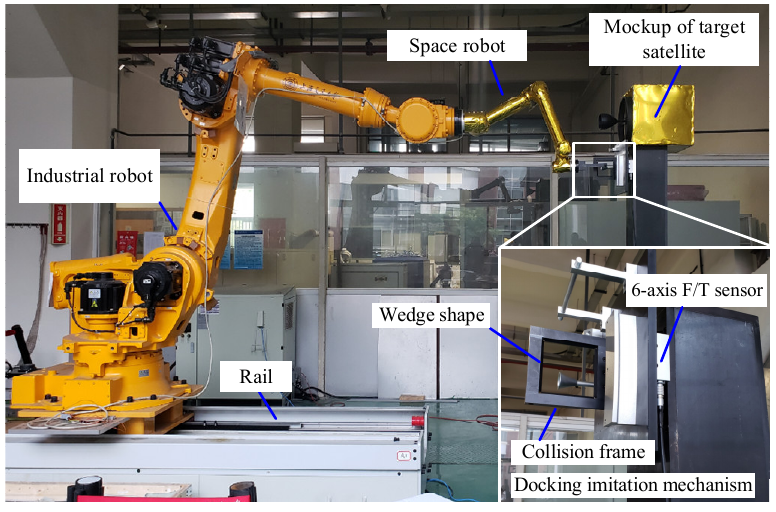
Figure 1. The HIL simulator.